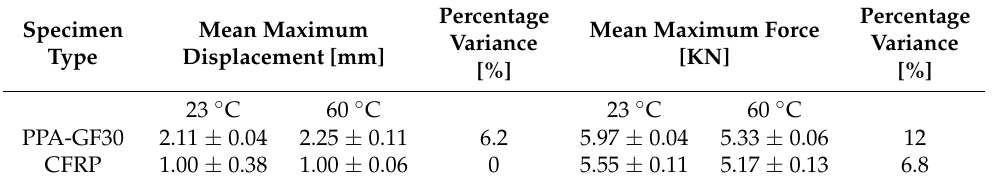
Table 2. Comparative analysis of PPA-GF30 and CFRP specimens at the two different testing